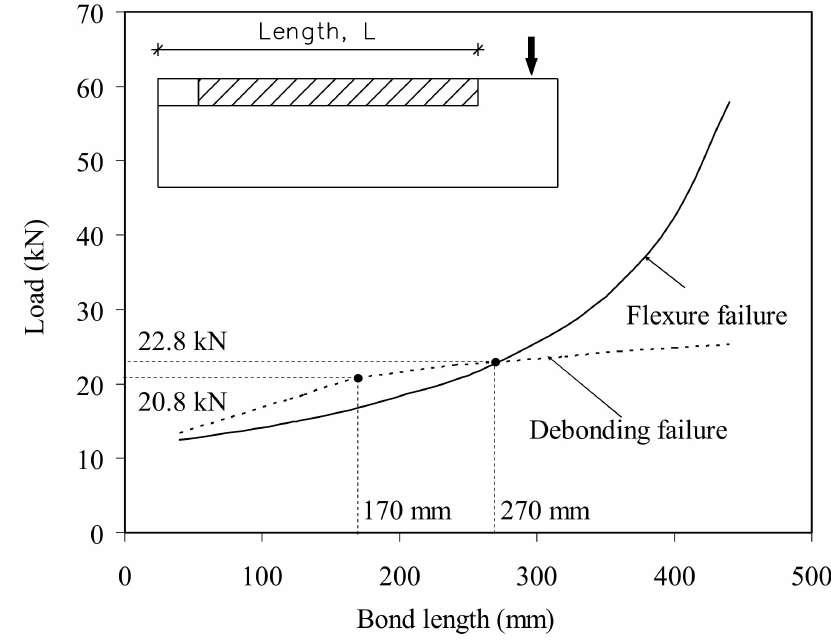
Figure 12. Effect of the bond length on the predicted ultimate load for the beams of Type